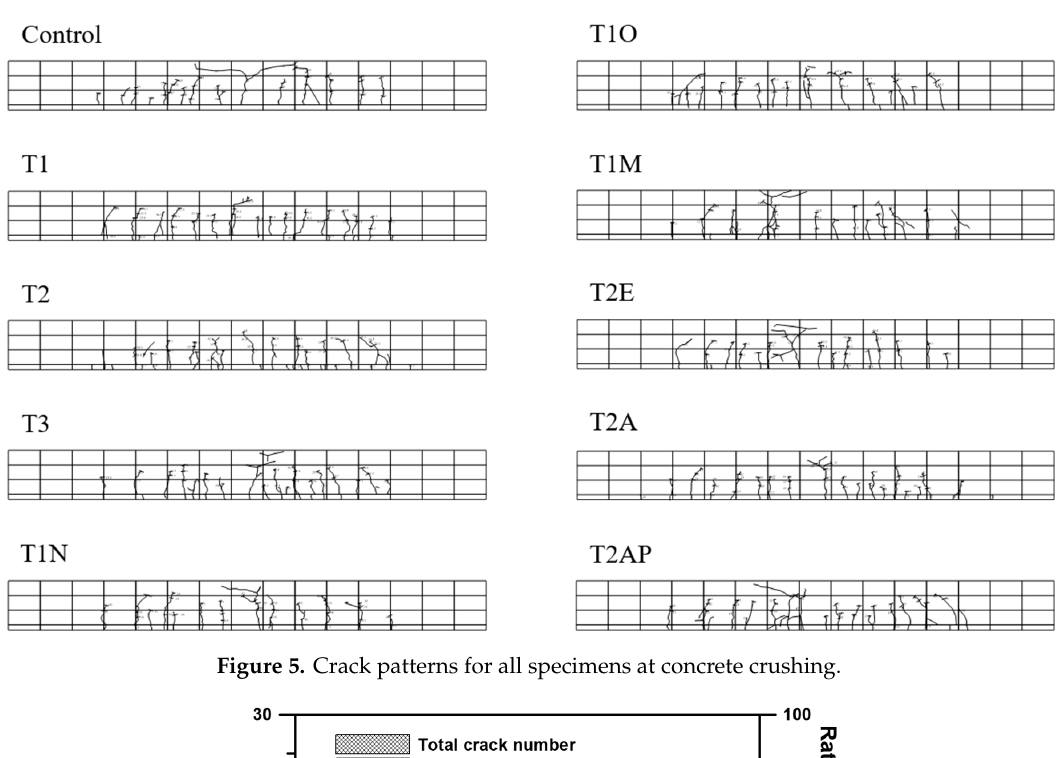
Figure 5. Crack patterns for all specimens at concrete crushing.